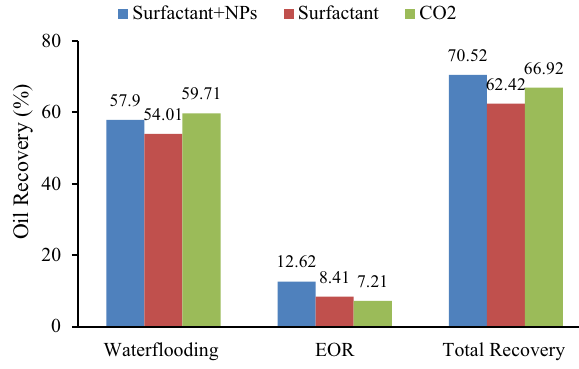
Fig. 7 Oil recovery following waterflooding, CO 2 and foam injection, fractured rock Fig. 8 Summary of coreflood experiments, fractured